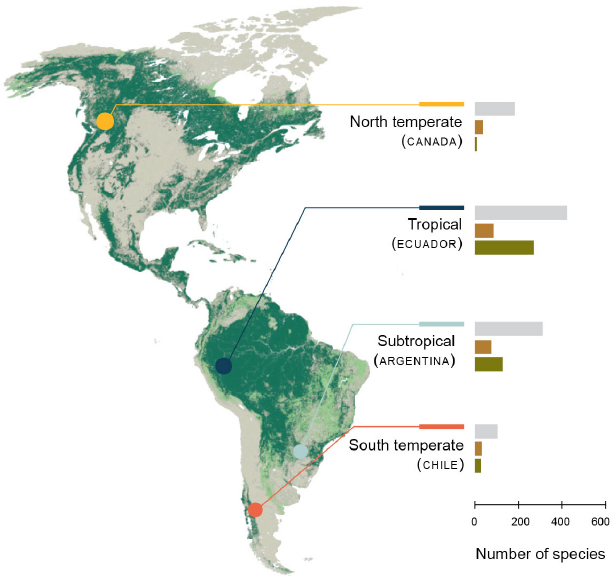
Fig. 2 . Species numbers of birds (grey bar), cavity-nesting birds (brown bar), and trees (green bar) in our study sites across the Americas. These sites represent a gradient of forests from relatively species-poor temperate systems at higher latitudes to species-rich subtropical and tropical forest areas at lower latitudes (closer to the equator). The distribution of forested areas in the continent is shown in